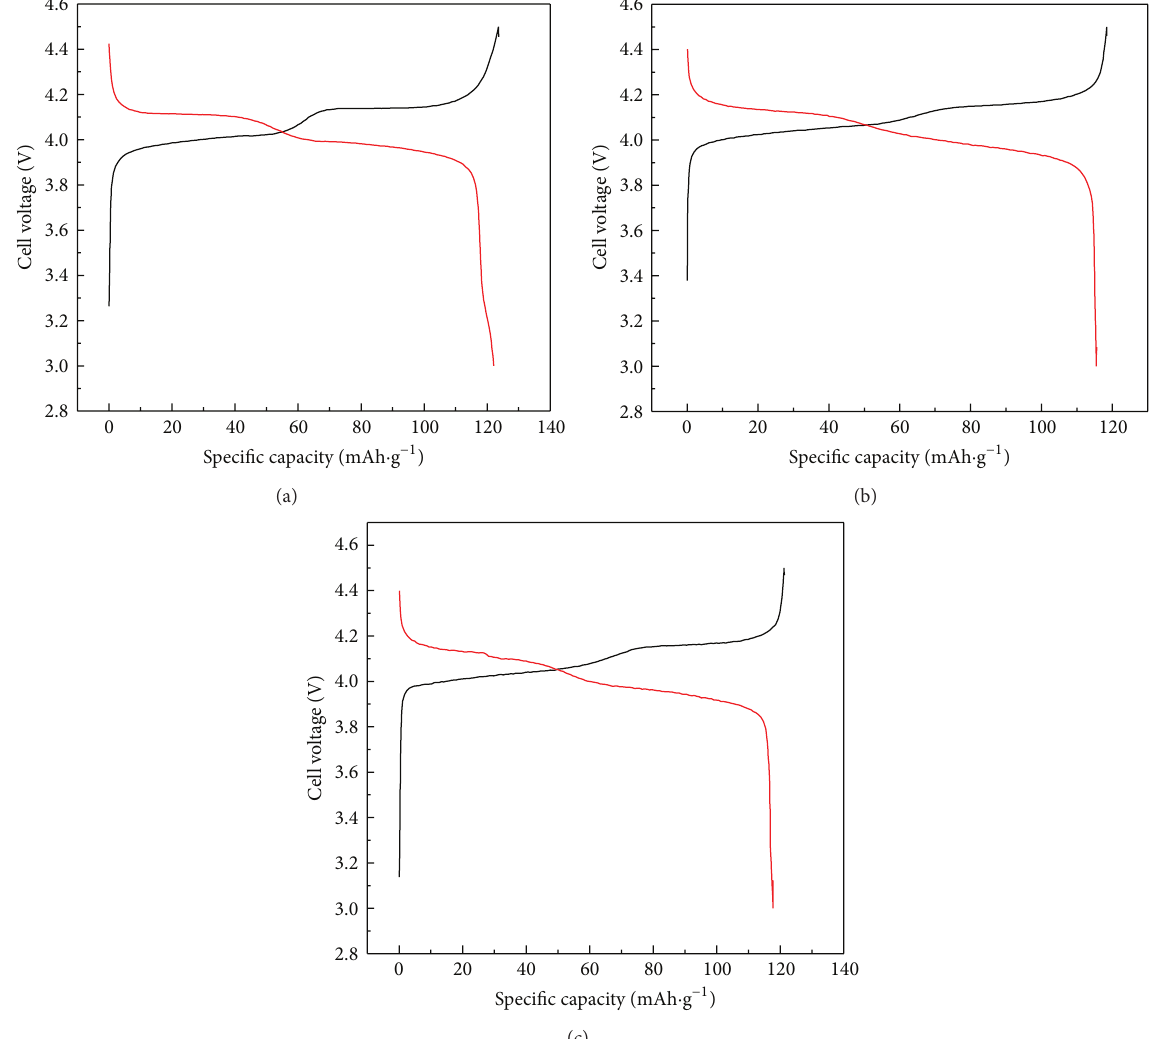
Figure 2: The charge-discharge curves of cells (a) Li/LiMn 2 O 4 , (b) Li/Li 1.02 Mn 1.92 Al 0.02 Fe 0.02 Cr 0.02 O 4 , and (c) Li/Li 1.02 Mn 1.92 Al 0.02 Fe 0.02 Cr 0.02 O 3.92 F 0.08